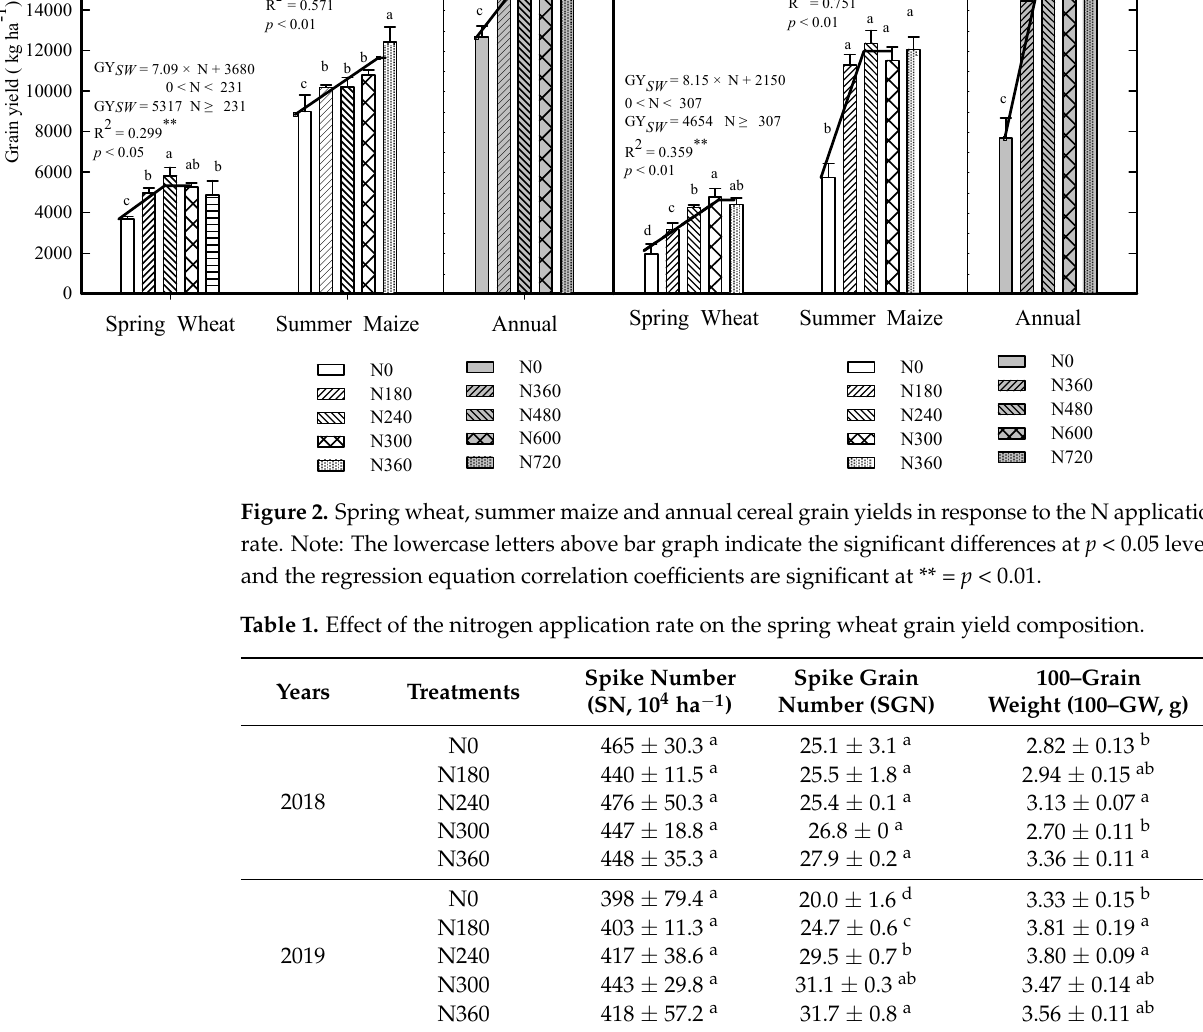
Note: The lowercase letters after values indicate the significant differences at p < 0.05